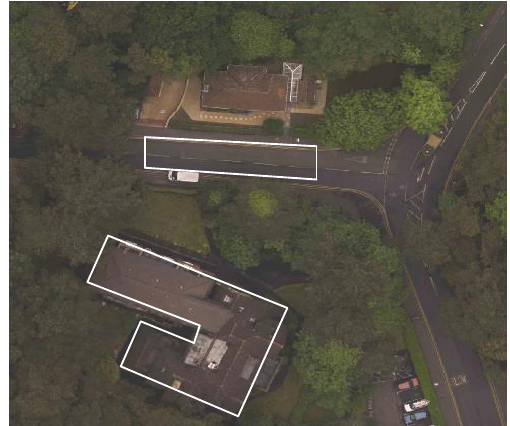
complex building